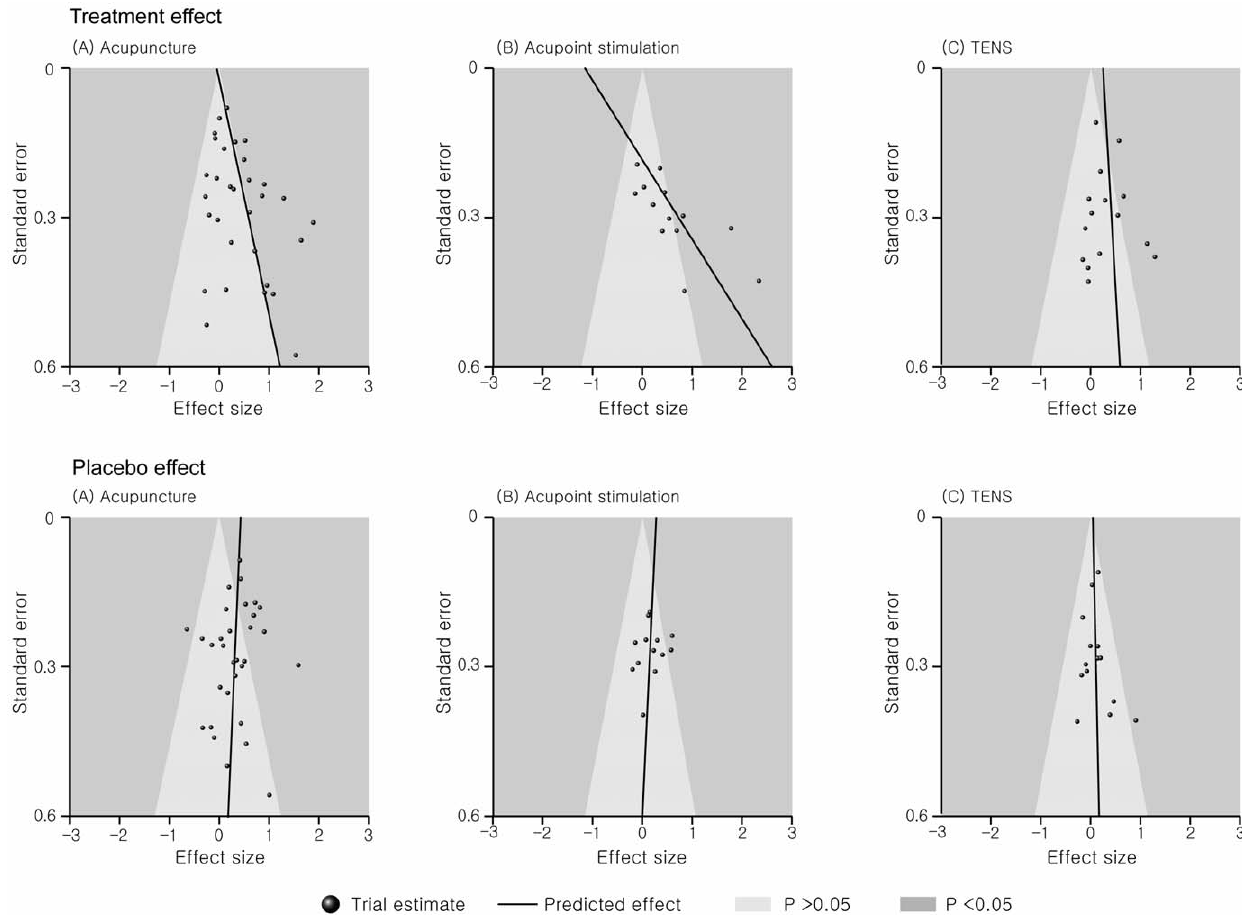
Figure 3. Contour-enhanced funnel plot including predicted lines from univariable meta-regression models.